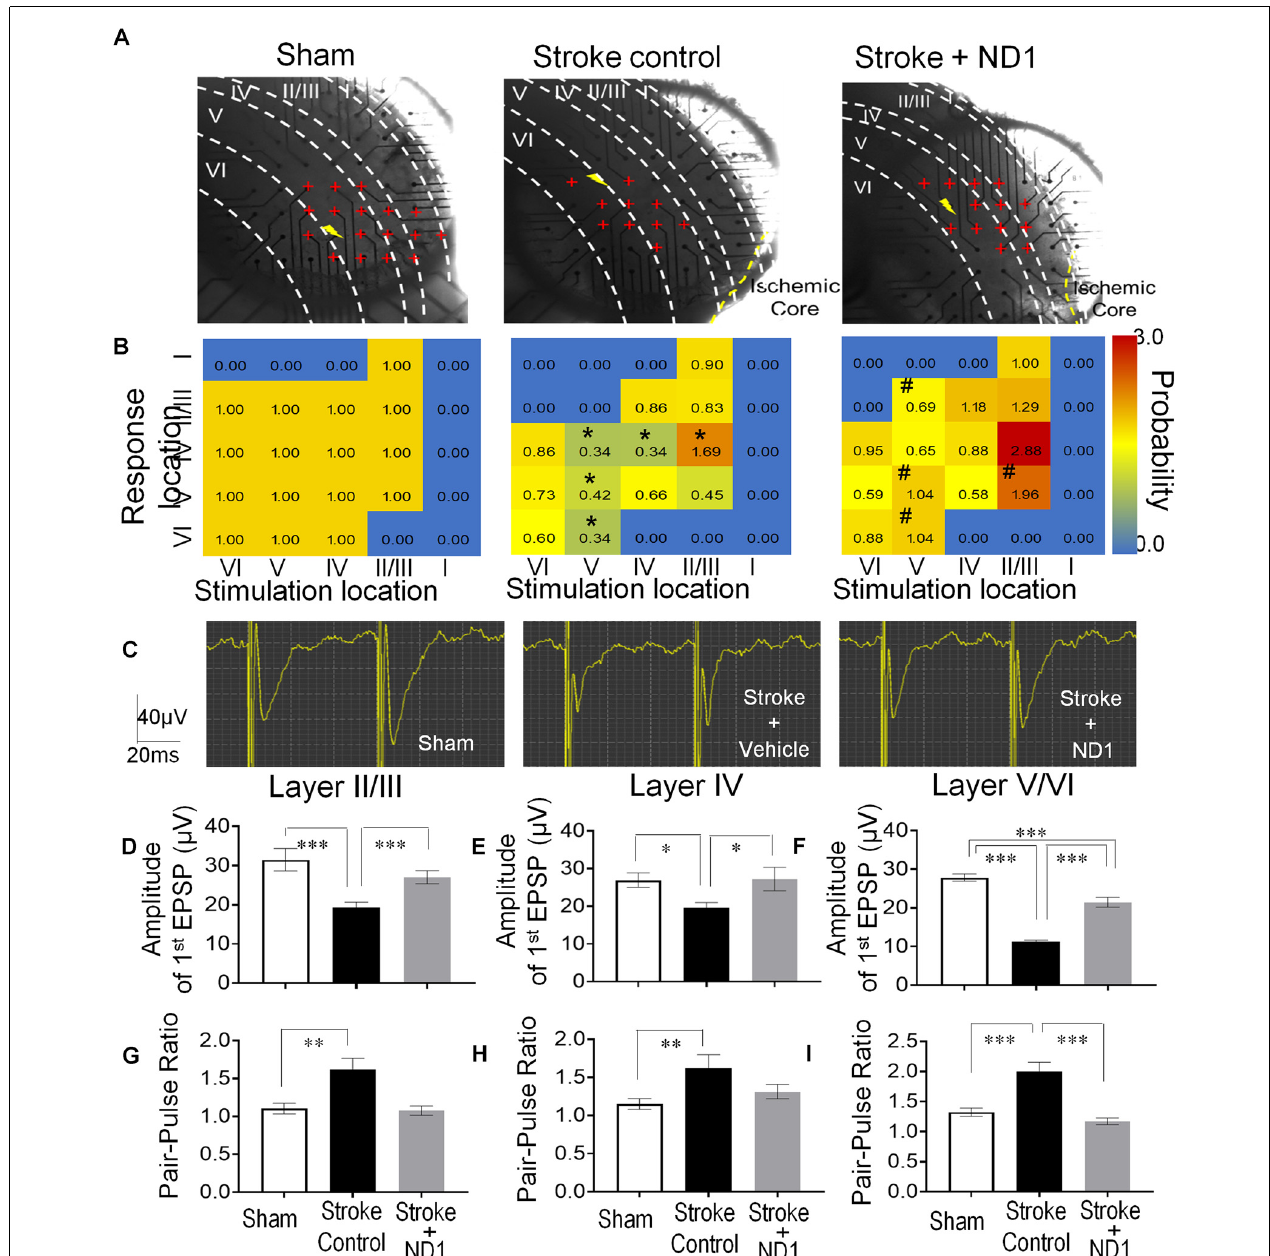
FIGURE 6 | Functional repair of neuronal networks in the ischemic cortex. The Multi-Electrode Array (MEA) recording was performed to detect neuronal connections and functional activities in the sensorimotor cortex of the brain sliced 42 days after stroke. (A) Photos of brain slices and locations of 59 recording electrodes (red cross) crossing the six cortical layers (I, II/III, IV, V, and VI) near the ischemic core or the similar area of the sham recording. The shock sign indicates the location of the stimulation electrode and red cross indicates the electrodes or area where evoked EPSPs can be recorded. (B) Heat maps of evoked EPSPs showing the location and intensity of the response. Non-response areas are shown in blue color, and responsive areas of evoked EPSPs are shown in a yellow to red spectrum according to the response probability normalized to sham controls. After a stroke, the EPSP response likelihood was significantly reduced or even disappeared in II/III, IV, V, and VI cortical layers ( n = 4–5 animals in each group, ∗ p < 0.05, vehicle vs. sham controls, the Chi-square test). In recordings from slices subjected to ND1 transduction, there were more responsive areas (e.g., layer II/III) and the response probability of EPSPs was significantly greater than that in stroke controls ( n = 4–5 animals in each group; # p < 0.05 vs. stroke controls, the Chi-square test). (C) Representative recordings of the pair-pulse facilitation. (D–F) Quantified data summarized from the pulse facilitation recording in different cortical layers. The amplitude of the first EPSPs was significantly smaller compared to sham control and it was restored in ND1-treated slices [ (D) F (2,561) = 8.8, (E) F (2,352) = 3.3, (F) F (2,1173) = 89.7, ∗ p < 0.05, ∗∗∗ p < 0.001, one-way ANOVA and Tukey’s post-hoc ]. (G–I) The ratio of the second to first EPSPs was significantly larger after stroke, while the ND1 treatment returned the ratio to the normal level. N = 4–5 per group, ∗∗ p < 0.05, ∗∗∗ p < 0.001 vs. sham or stroke controls [ (G) F ∗ p < 0.05, ∗∗∗ p < 0.001, one-way ANOVA and Tukey’s post-hoc (2,91) = 10.2, (H) F (2,68) = 5.2, (I) F (2,189) = 16.8,